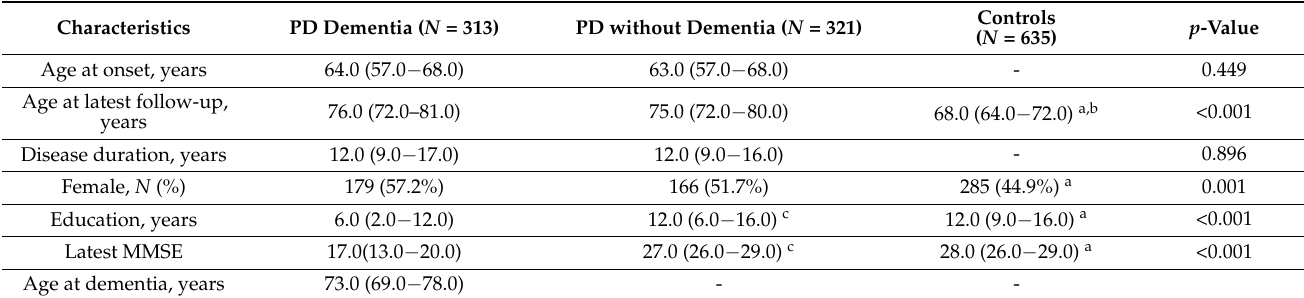
Table 1. Baseline clinical characteristics of the study